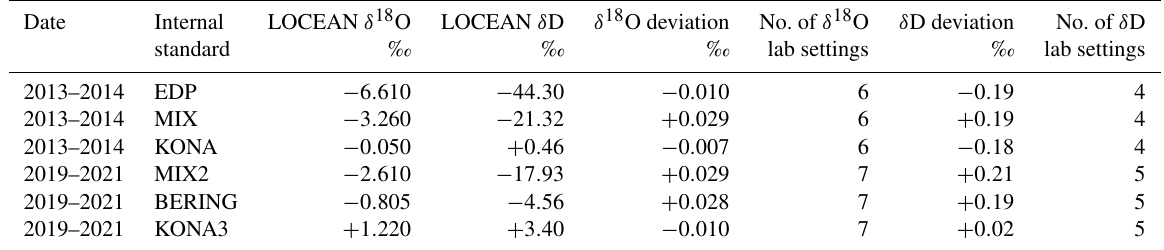
Table 1. Comparison of standards measured at LOCEAN and in other laboratories (in ‰). The 2013–2014 laboratory comparisons took place at LSCE (France), LDEO (Columbia University, USA), NIOZ (Netherlands), VRIJE (Brussels, Belgium), Dalhousie Univ (Dalhousie, Canada), BGS (Nottingham, UK), U. Ottawa (Ottawa, Canada), and in 2018–2019, at Geozentrum Nordbayern (Erlangen, Germany), AWI (Bremerhaven, Germany), U. Kiel (Kiel, Germany), LSCE (France), and U. Bergen (Bergen,